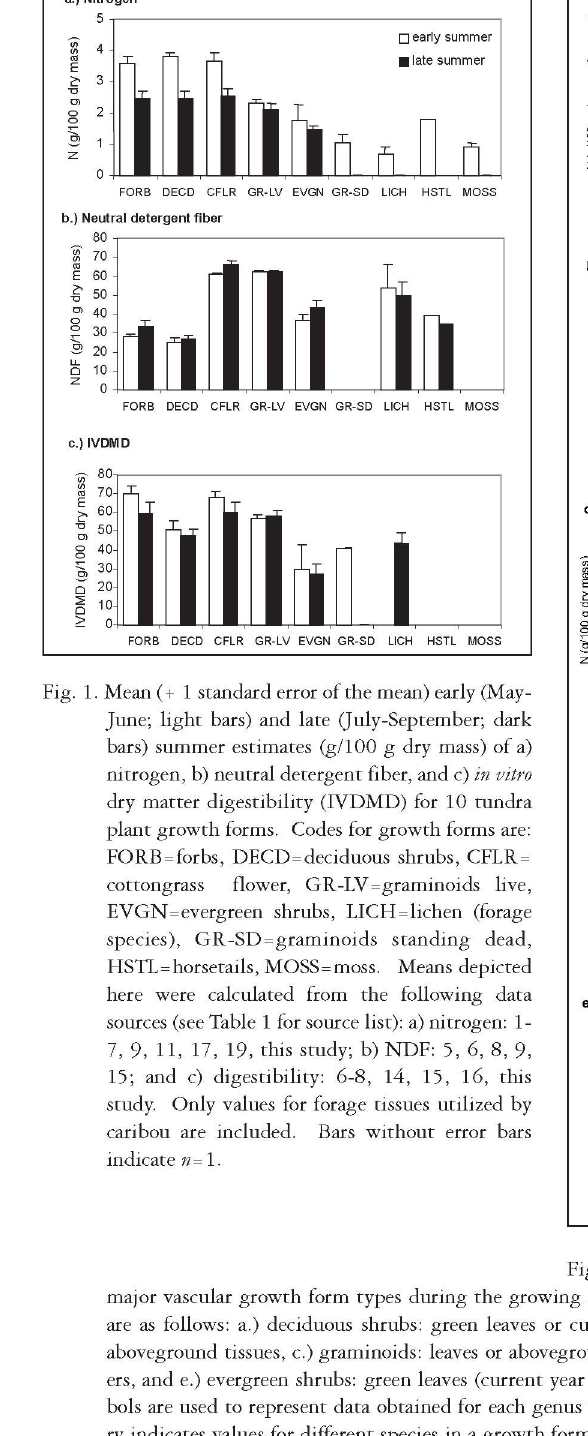
Fig. 2. Nitrogen concentrations (g/100 g dry mass)